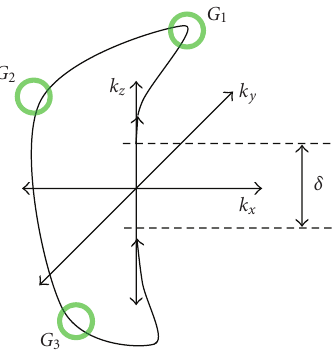
Figure 2: Diagram showing a trajectory going through specified goals at maximum resolution. δ is a gap in the sampling, chosen to correspond with the rf